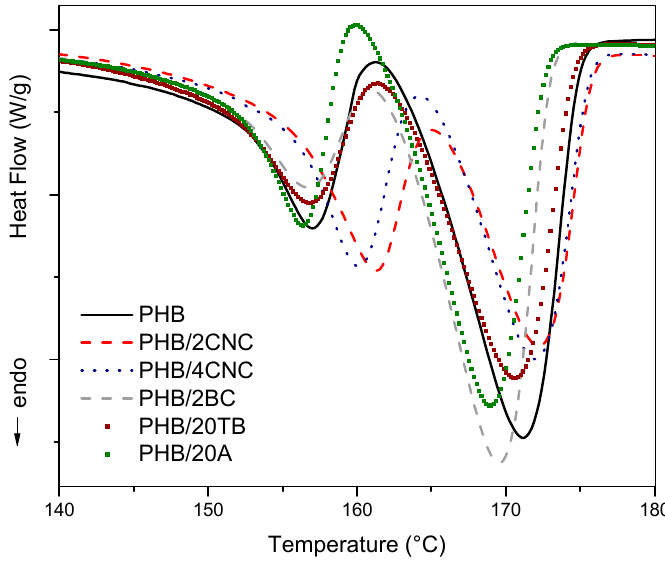
Figure 6. DSC curves of PHB and PHB binary samples.